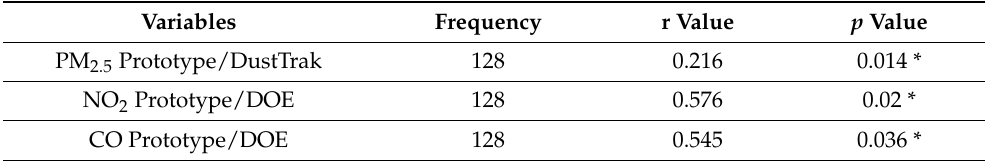
Table 4. Correlation test for PM 2.5 , NO 2 , and CO.